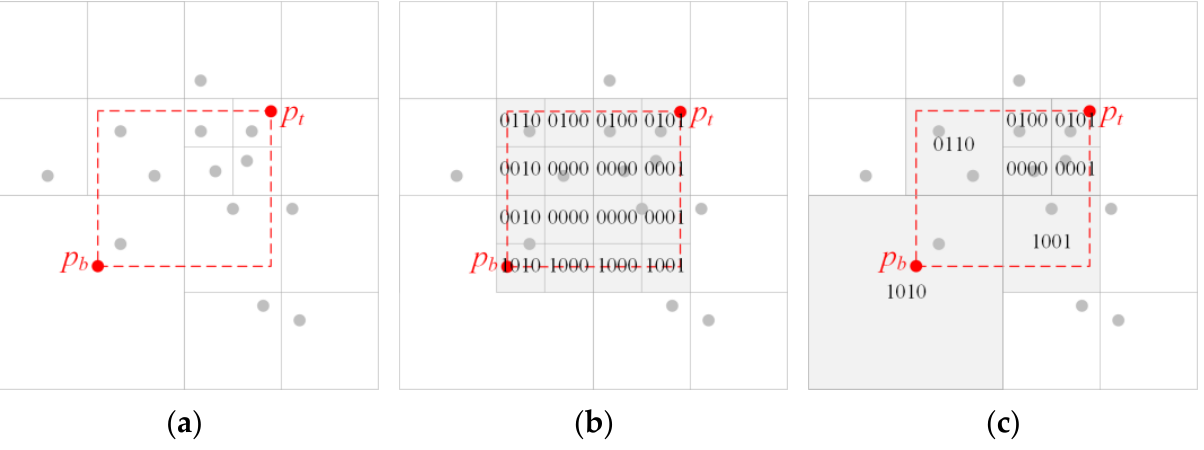
Figure 3. Range query processing in SLBRIN. ( a ) Spatial range query. ( b ) Use spatial location code to mark candidate range s. ( c ) Filter candidate HR s.